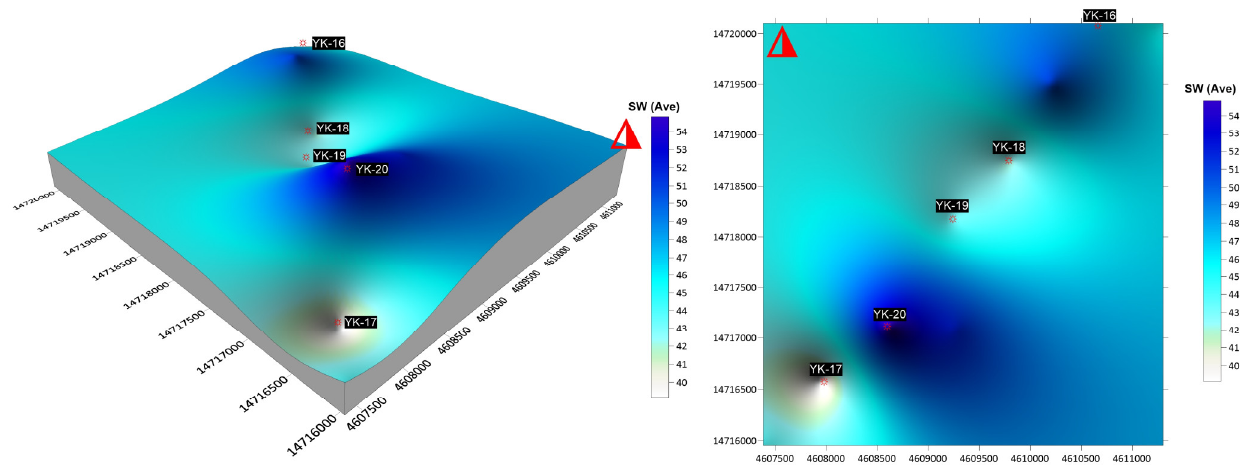
Figure 14. Water saturation (Sw) map (calculated in %).